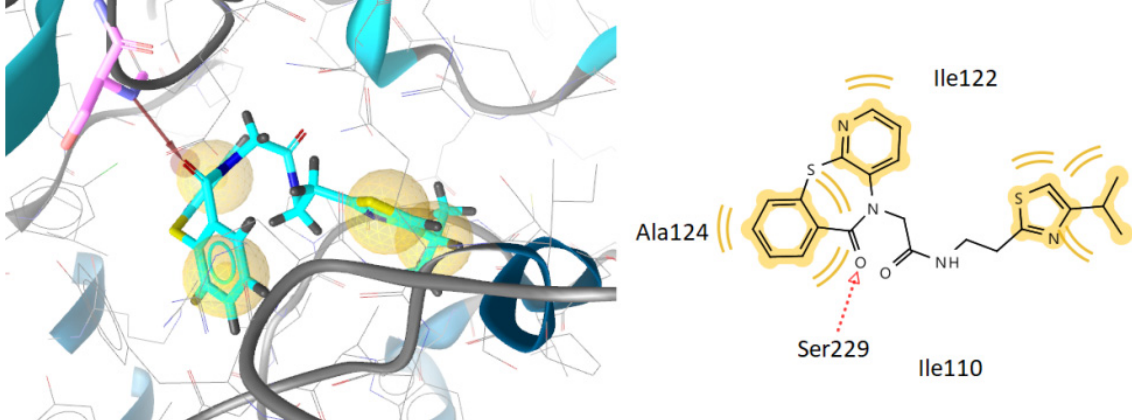
Figure 3. Docked conformation of the most active compound 2 in E. coli MurB. Red dotted arrows indicate H-bond, and yellow spheres indicate hydrophobic interactions.